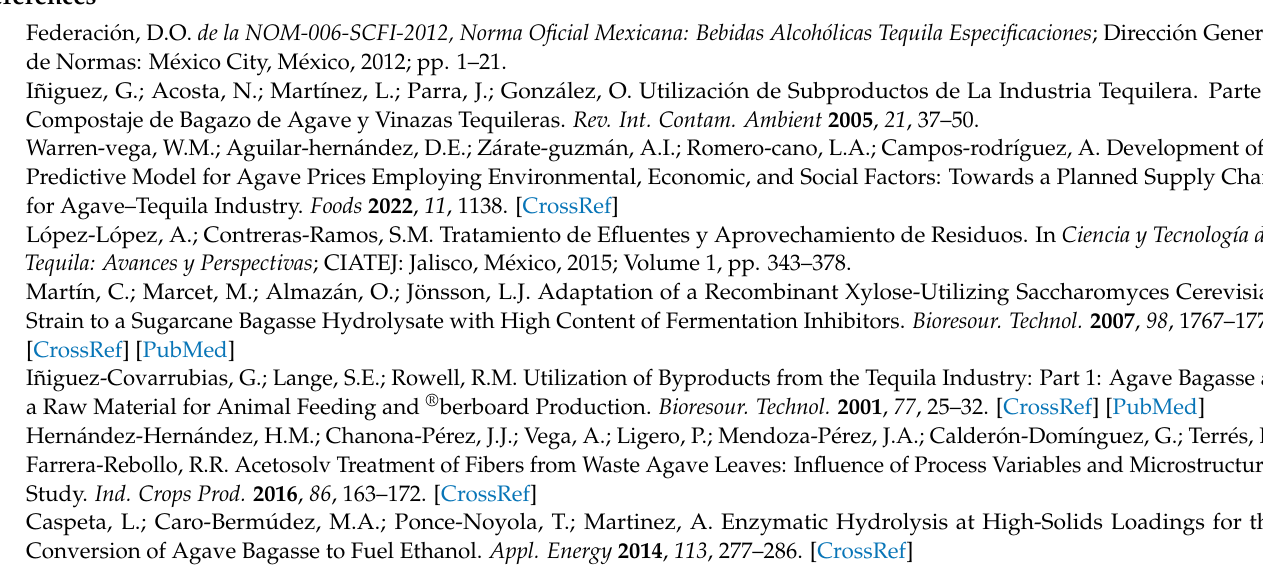
Table S2. Mathematical models used to describe the adsorption process in batch and fixed bed.